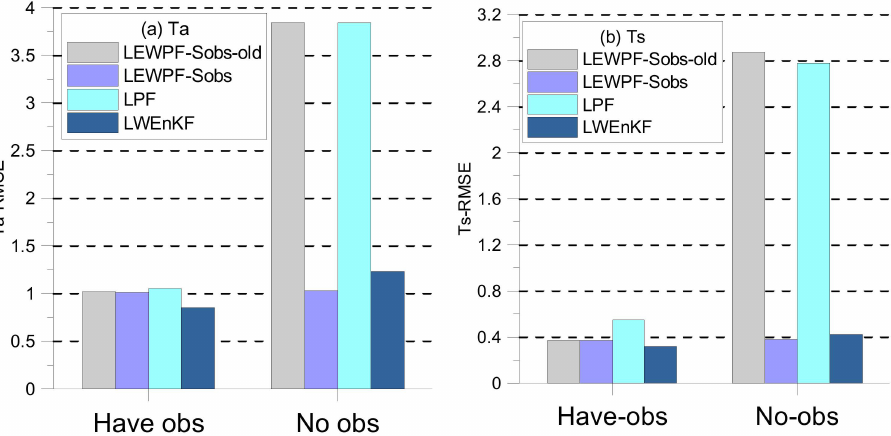
Figure 11. The RMSE histogram of the grid points with different observation situations. The RMSE of the variable T a based on the LEWPF-Sobs-old (gray), LEWPF-Sobs (pastel blue), LPF (ice blue) and LWEnKF (desert blue). The panel ( b ) is similar to the ( a ) but for the variable T s